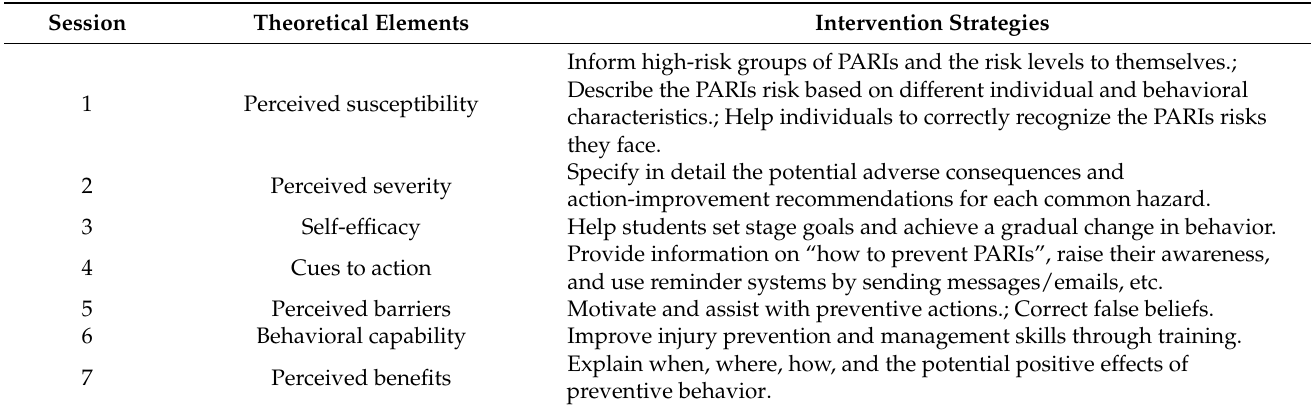
Table 1. The details of the prescribed intervention program among junior middle school